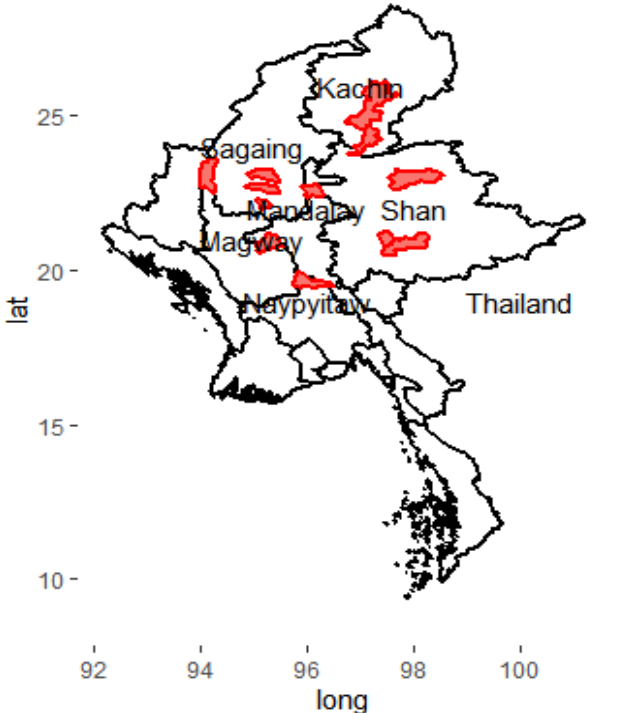
Figure 1. Selected townships among regions and states of Upper Myanmar. The red colour indicates the selected study sites.